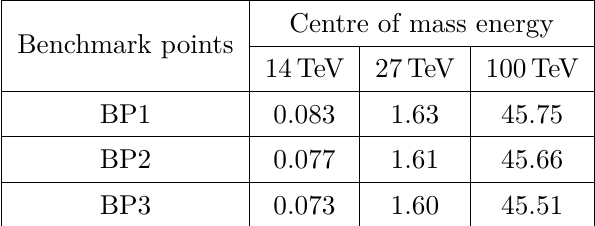
model. The red star B − L